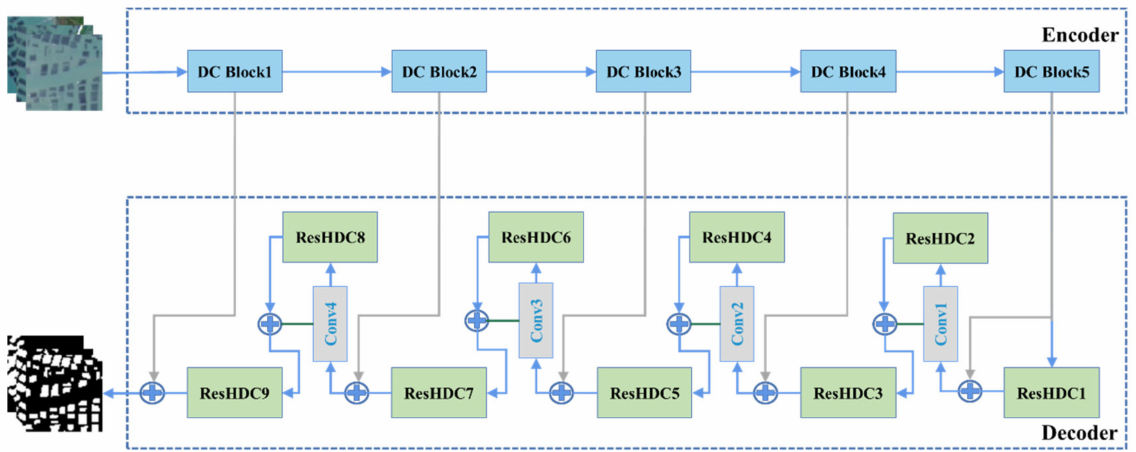
Figure 2. A simplified structure of RaftNet. The upper part represents the encoding structure, and the lower one represents the decoding